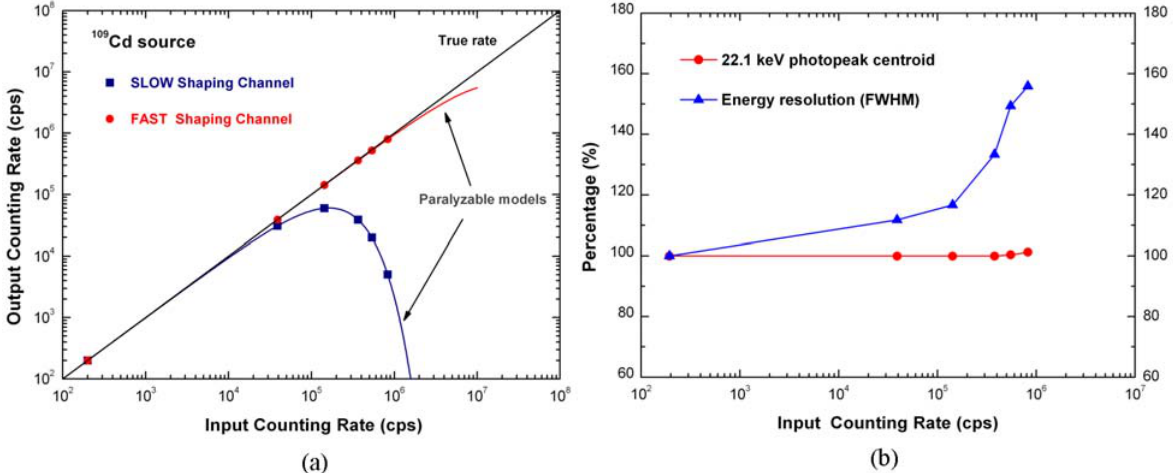
Figure 2. ( a ) Throughput of the system: the measured photon counting rates from “fast” and “slow” channels (red and blue points, respectively) versus the true input counting rate. The red and blue lines are the paralyzable dead time model functions for the “fast” (dead time of 60 ns) and “slow” (dead time of 6.14 µs) channels, respectively; ( b ) The 22.1 keV photopeak centroid and energy resolution (FWHM) at 22.1 keV (percent deviation from the values at 200 cps).